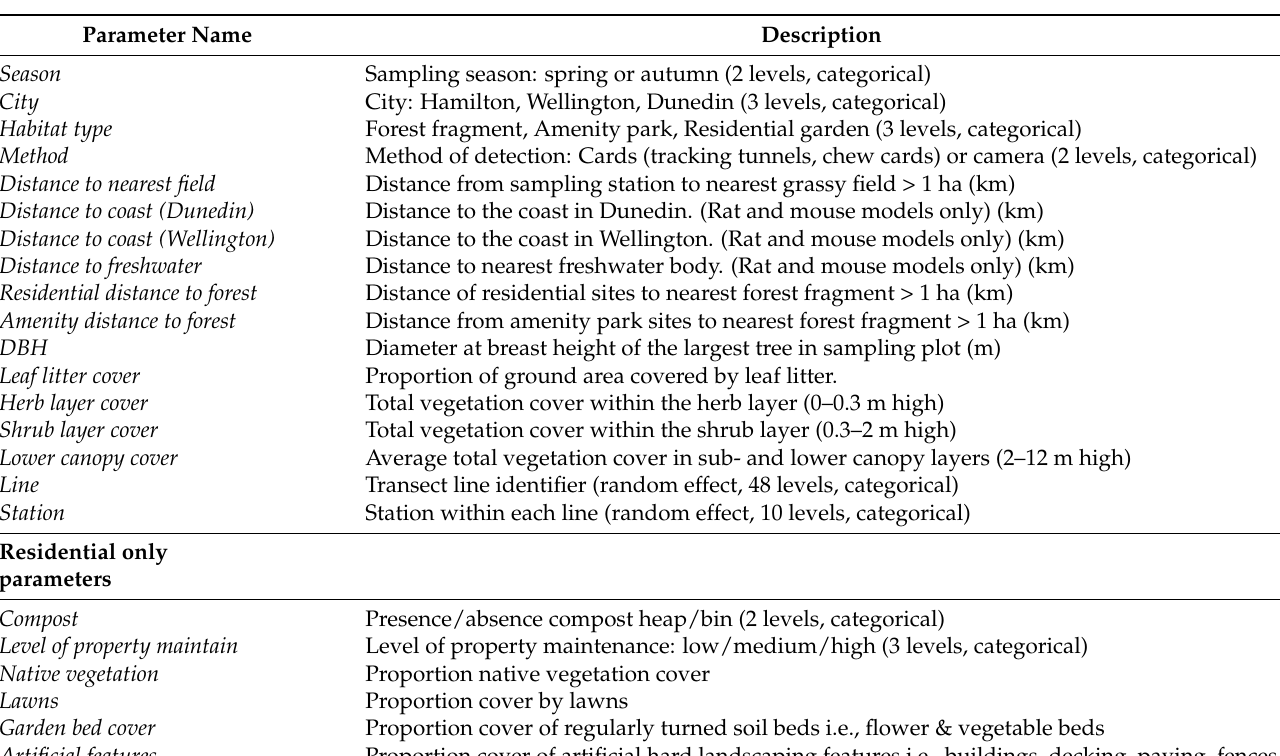
Table 1. List of parameters and their units in the base models for each mammal species. Proportion data range between 0 and